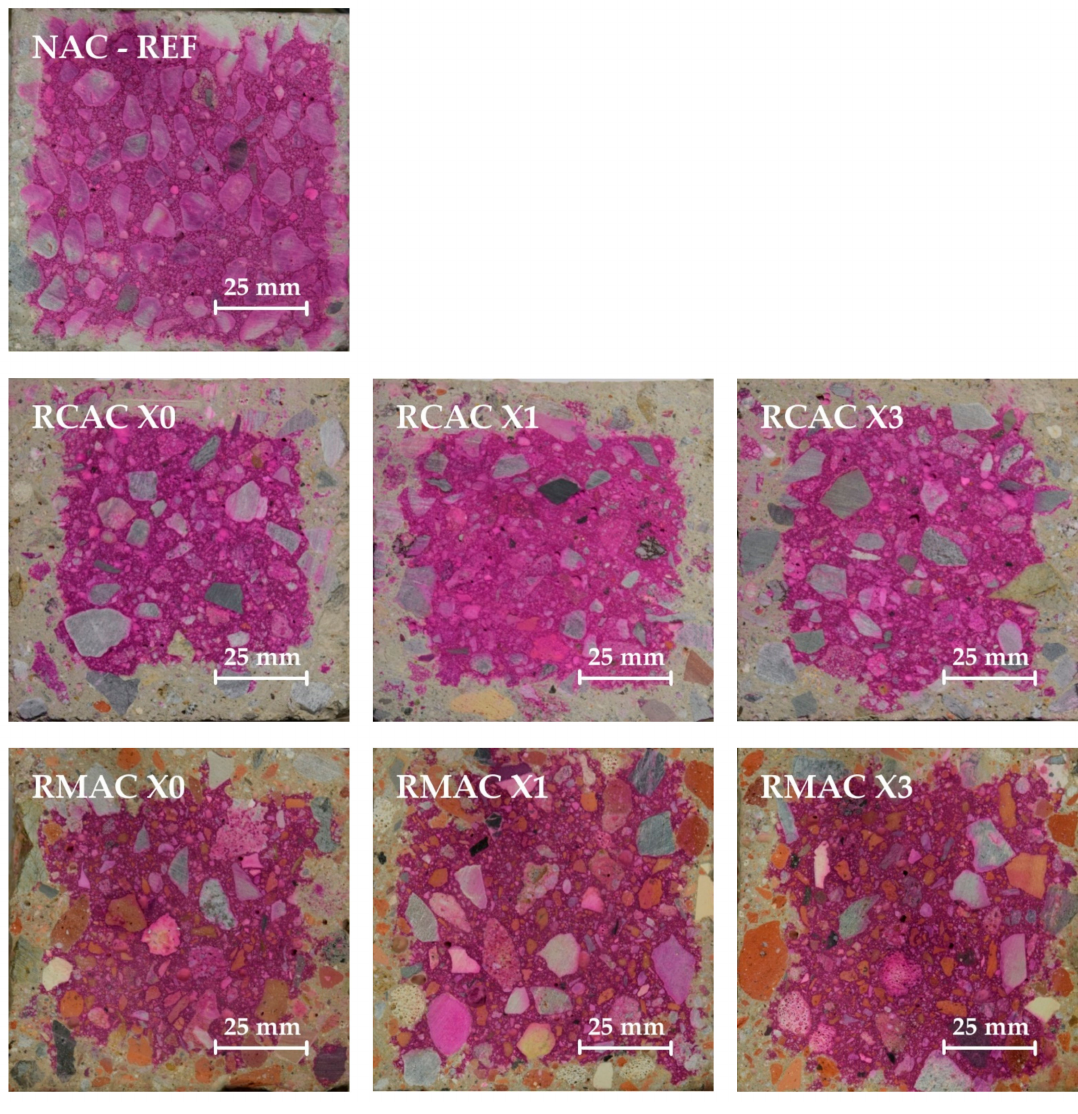
Figure 8. Carbonation depth of NAC, RCAC, and